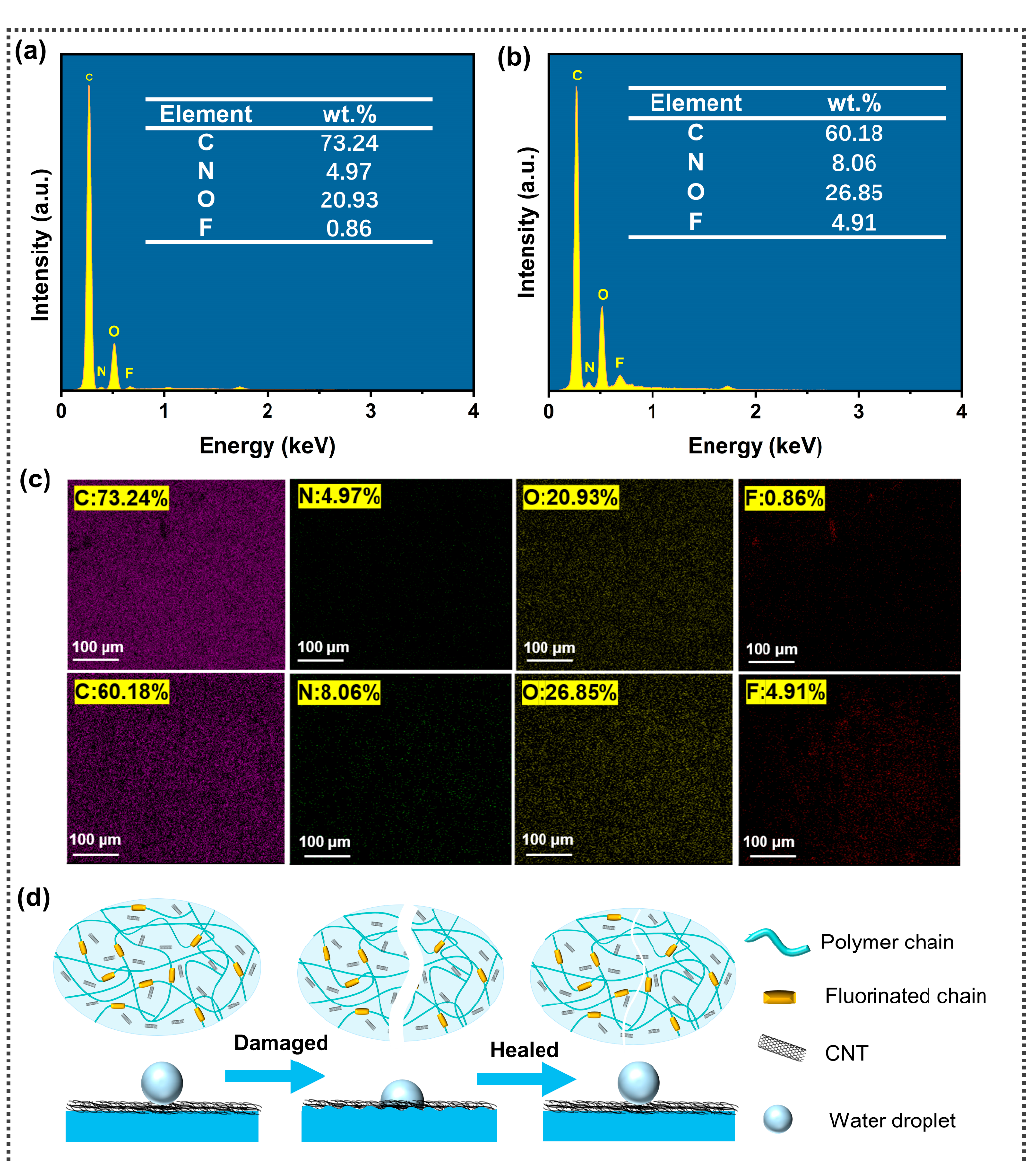
Figure 6. EDS spectrum of SFPUHE-HTF-CNTs : ( a ) before being damaged and ( b ) after self-healing. ( c ) Element distribution maps of SFPUHE-HTF-CNTs before being damaged and after self-healing. ( d ) Diagram of the hydrophobic self-healing mechanism of SFPUHE-HTF-CNTs.